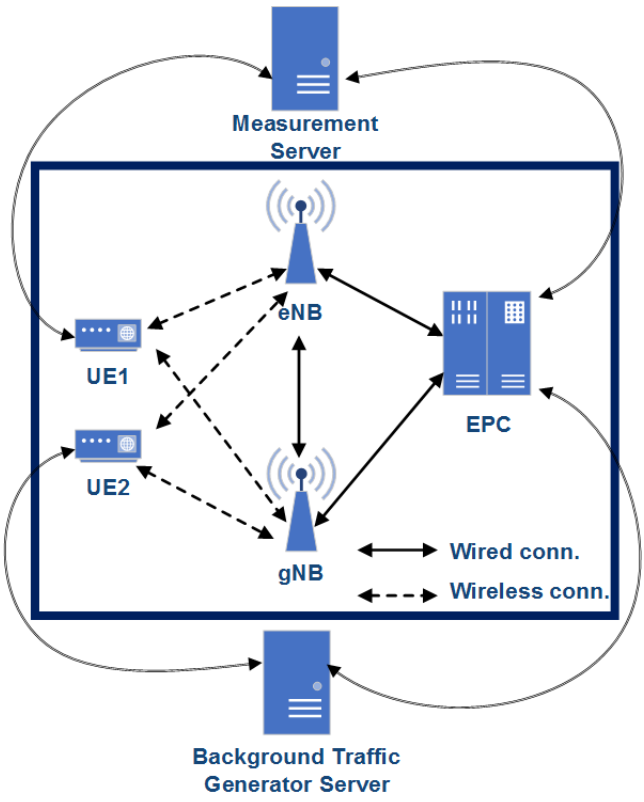
Figure 18. The architecture of the 5G testbed—as Option 3X; Measurement Server: NMAP measurement traffic; Background Traffic Generator: Iperf and T-rex background traffic